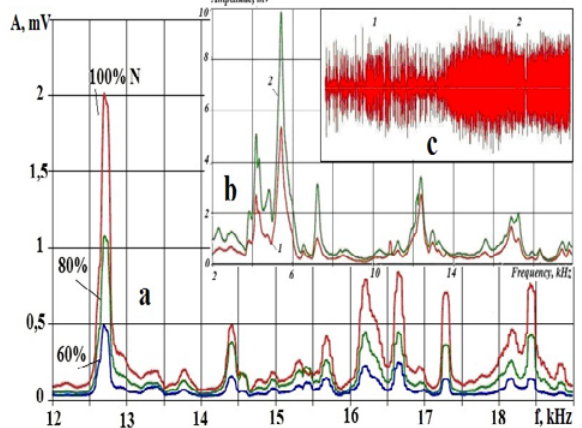
Fig. 3. The spectra of VA signals during laser machining (a) and EDM (b) at different energy deposition powers. In the insert “c”, the sections of recording the VA signal for low (1) and high pulse frequencies are shown